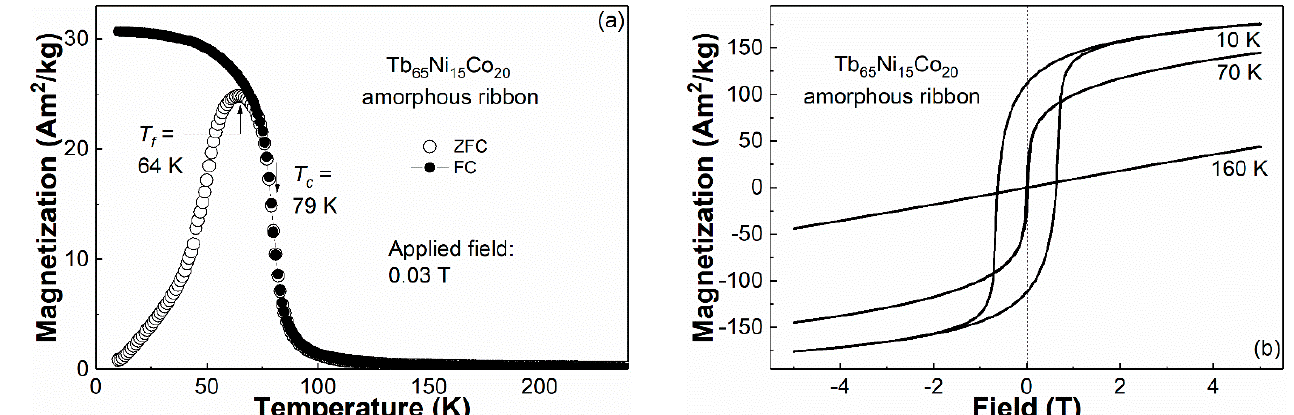
Figure 3. ( a ) FC and ZFC M - T curves of the Tb 65 Ni 15 Co 20 amorphous ribbon under a magnetic field of 0.03 T; ( b ) the hysteresis loops of the amorphous ribbon measured at 10, 70 and 160 K. (The magnetization can be transformed to be SI unit according to 1 Am 2 /kg ≈ 120 A/m).